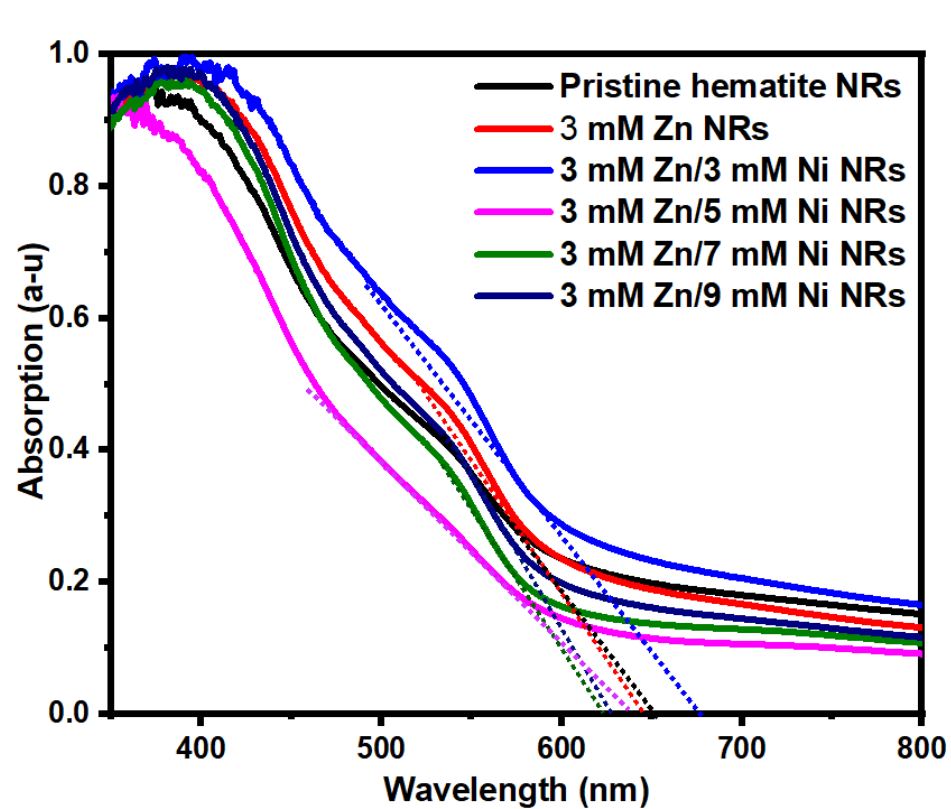
Figure 8. Absorption spectra of hematite NRs co-doped with different Zn/Ni concentrations.